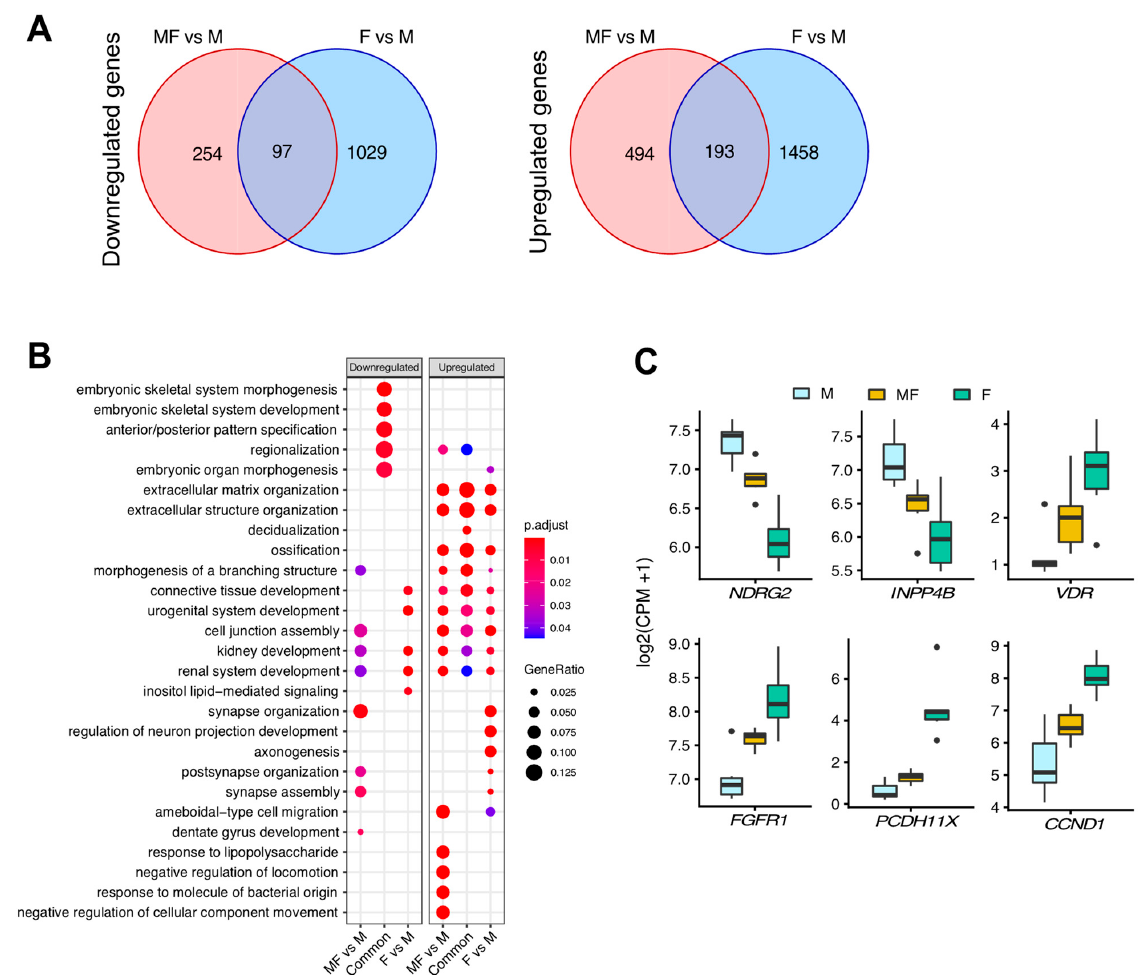
Figure 3. Up and downregulated overlapping DEGs in myometrial samples from fibroid patients vs myometrial samples from non-fibroid patients (MF vs. M) and fibroids vs myometrial samples from non-fibroid patients (F vs. M). Venn diagrams illustrate the overlap of the down ( A ) and upregulated genes between MF vs. M and F vs. M. ( B ) Top overrepresented Gene Ontology pathways analyses for MF vs. M-specific, shared, and F vs. M-specific up and downregulated gene sets. Gene enrichment ratio and significance levels are shown by the size and color of each circle, respectively. ( C )Boxplot of significant up or downregulated genes (false discovery rate p -value < 0.05 and fold change > 2) associated with fibroids and tumorigenesis ( n = 6/group). Gene expression is shown as log 2 (CPM + 1).